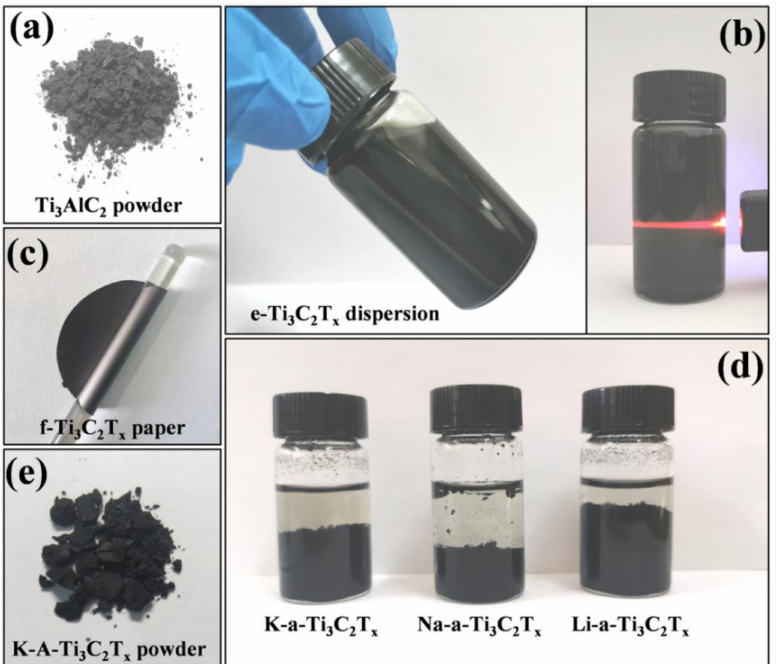
Figure 2. Appearance of the samples: ( a ) Ti 3 AlC 2 powder, ( b ) e-Ti 3 C 2 T x , ( c ) f- Ti 3 C 2 T x